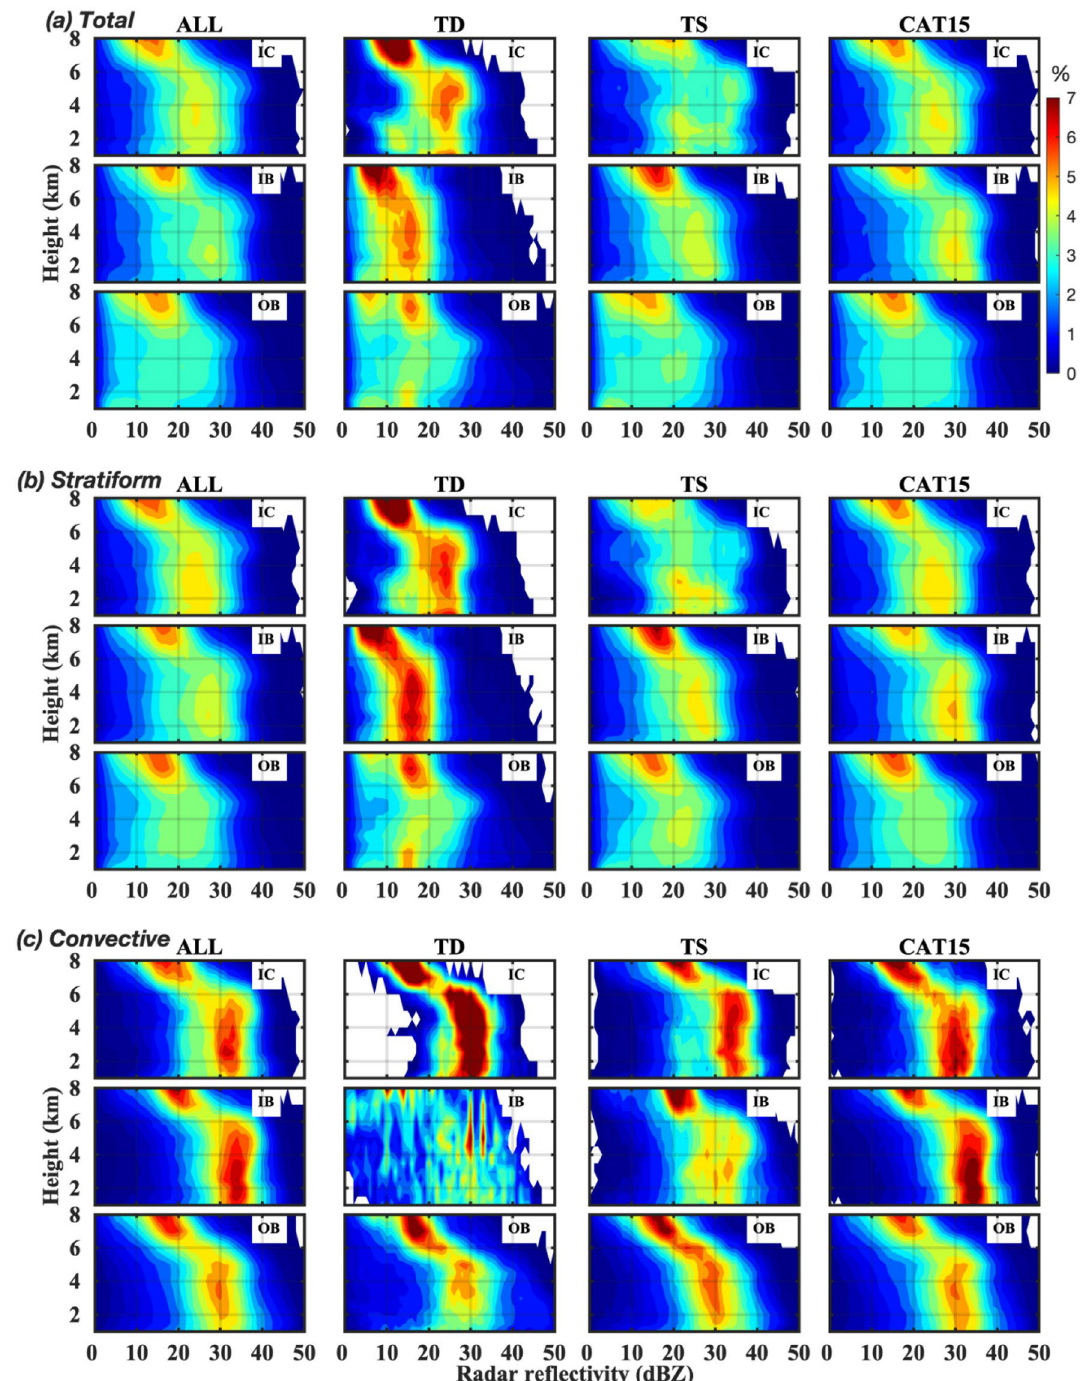
Figure 6. Echo profiles of different category TCs at different rain regions. The contour frequency by altitude diagrams (CFADs) of radar reflectivity for TCs of all categories, TDs, TSs and CAT15 at different rain regions (IC: inner core, IB: inner band, OB: outer bands). ( a ) Total precipitation, ( b ) stratiform precipitation, and ( c ) convective